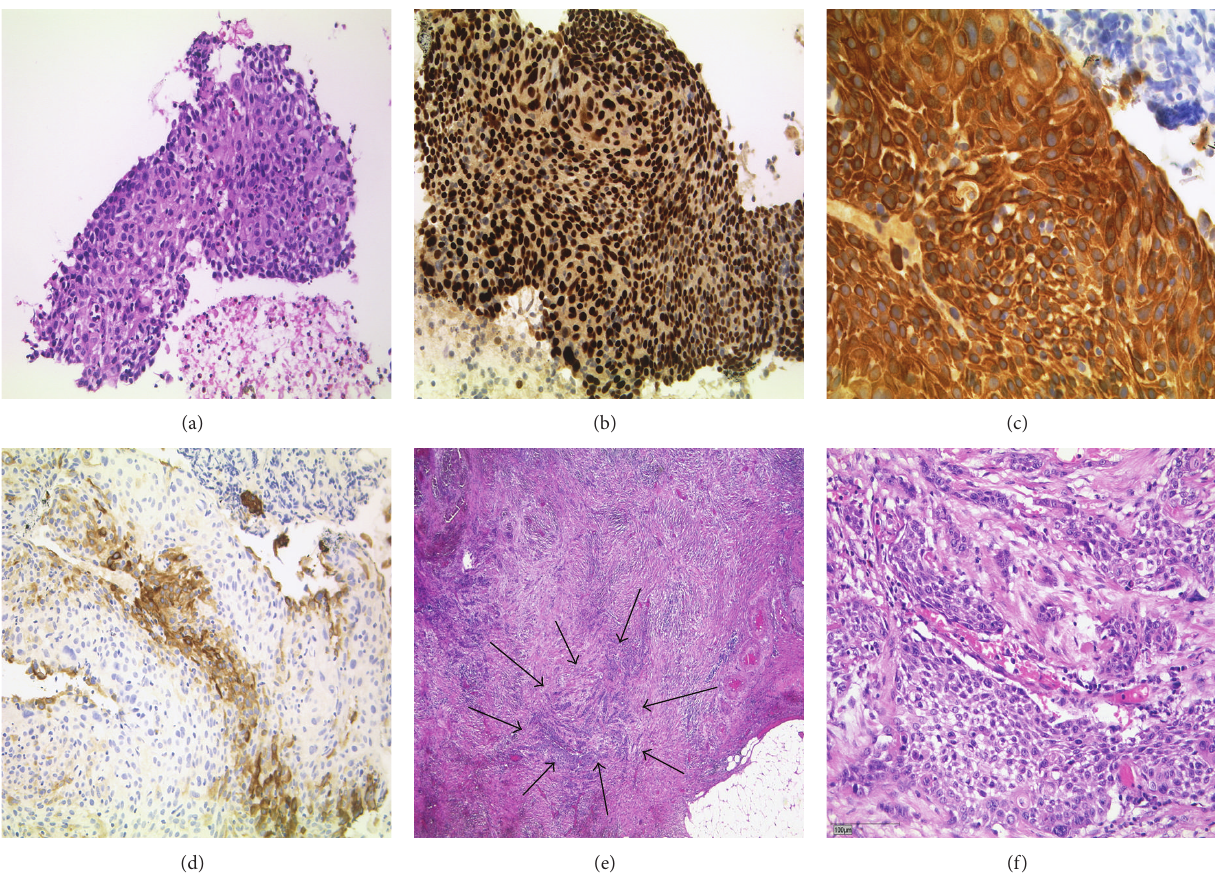
Figure 3: Histology and immunohistochemistry. Tumor biopsy (pretreatment): (a) solid mass of cohesive, discretely pleomorphic cells of intermediatesizewithhyperchromatic,pleomorphicnuclei(H&E,originalmagnification: × 100).(b)Immunohistochemistryrevealednuclear positivityforp63( × 200).StrongcytoplasmaticpositivityforCK5/6,((c), × 400).CK7stainingresultsinonlyfocalweakpositivityoffewtumor cells ((d), × 200). Histology of resection specimen (after treatment). (e) Overview of tumor extension, large areas of fibrosis were seen; small circumscribed area of vital tumor is indicated by arrows (H&E, × 25). Closer view on vital tumor cells resembling pretreatment morphology ((f), H&E ×